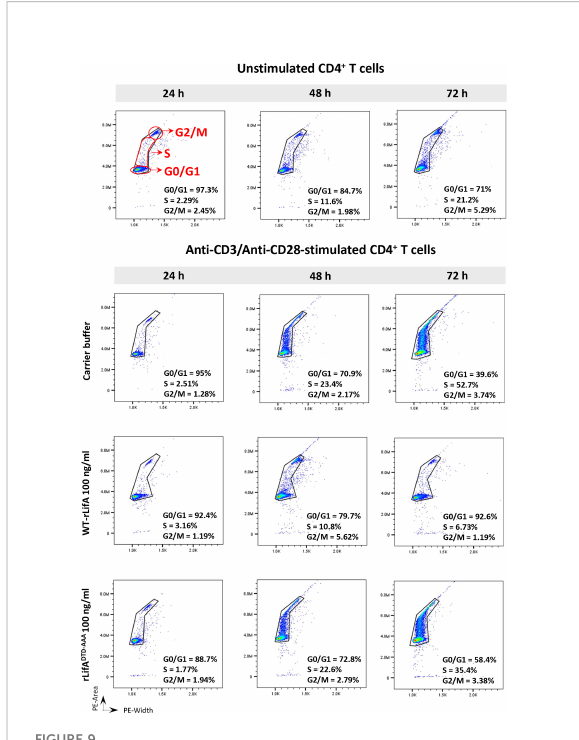
FIGURE 9 Lymphostatin arrests the cell cycle in G0/G1 phase in anti-CD3/ anti-CD28-stimulated CD4 + T cells throughout 72 h incubation period. Histograms represent the DNA contents of G0/G1, S, and G2/M phases in the unstimulated (without treatment) and anti- CD3/anti-CD28-stimulated CD4 + T cells treated with WT-rLifA, rLifA DTD-AAA , or carrier buffer at incubation time of 24, 48, and 72 h. Representative data using cells from one donor are